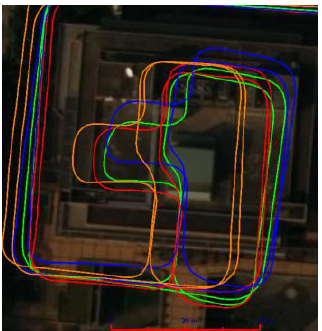
Figure 9. The trajectories from different integration results